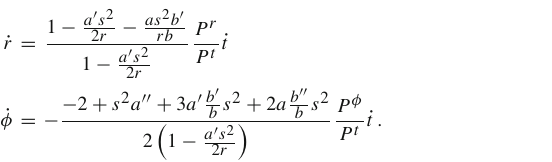
Fig. 10 The behavior of the velocity square u μ u μ / panel for σ = 0 . 1, central panel for σ = 0, and right panel for σ = − 0 .